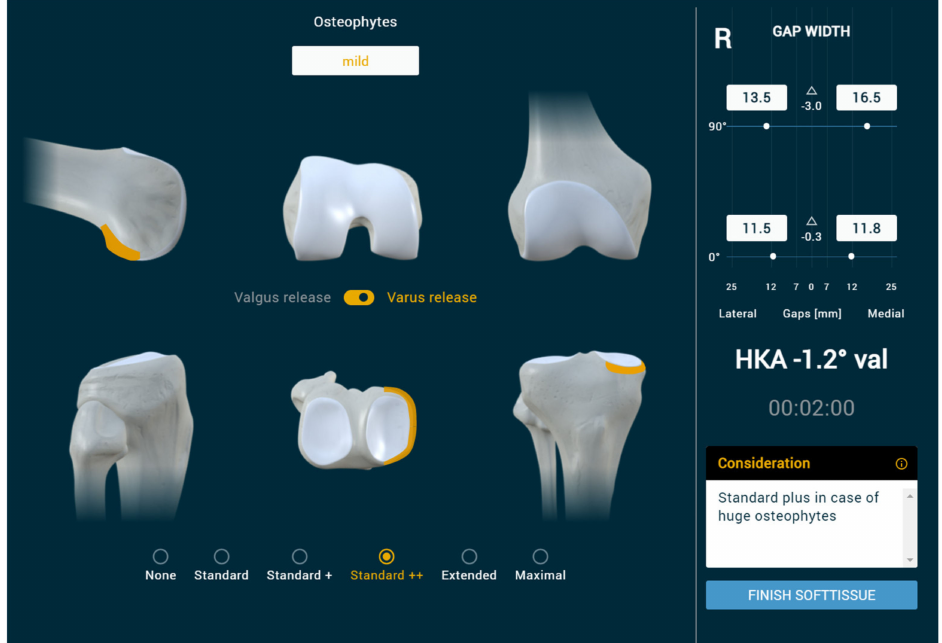
Figure 3. Different release steps are listed at the bottom and can be chosen based on gap differ- ences or workflow. This can be performed for varus and valgus knees. The anatomical region of release/osteophyte removal is demonstrated depending on the category from none (just approach) to maximal (including the superficial MCL). In this case, std ++ was chosen, demonstrating the removal of osteophytes all around the medial tibia and the posterior femoral